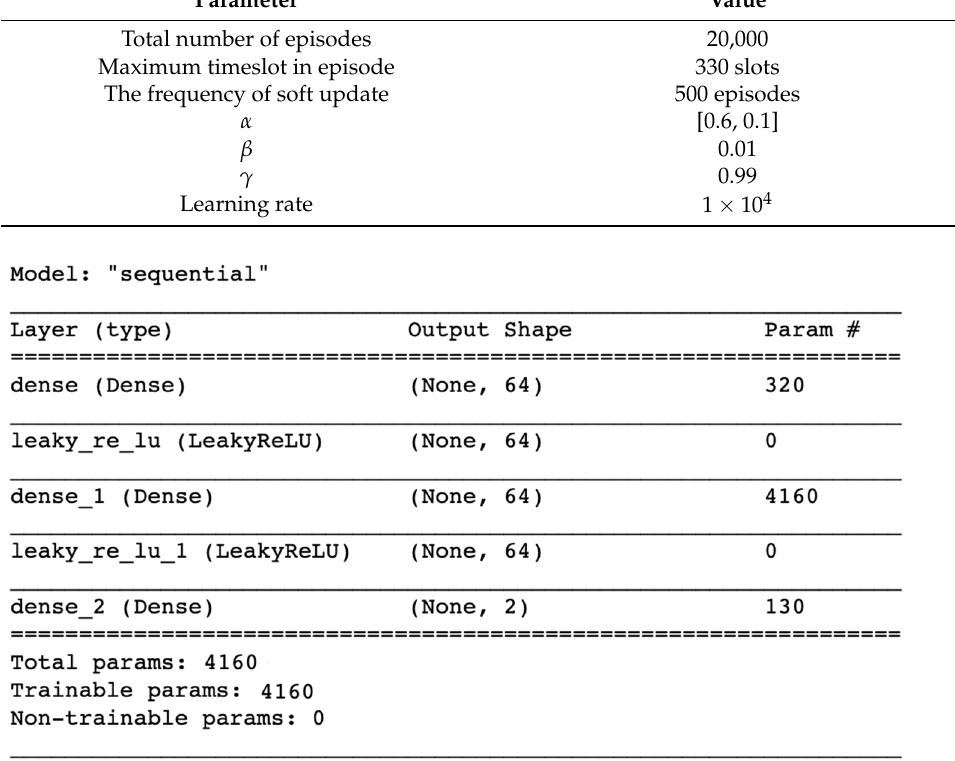
Figure 4. Neural network model summary. Three Dense Layer was stacked with LeakyReLU activation. Linear activation was used for the output.